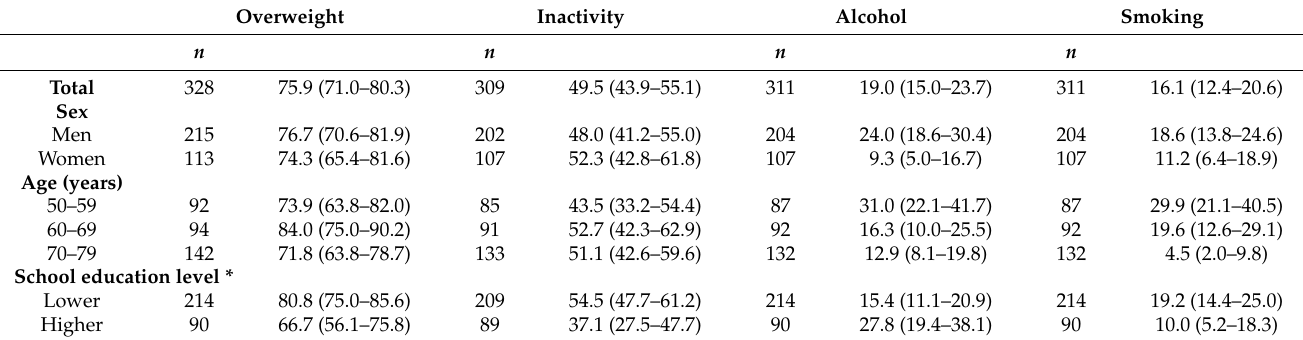
Table 2. Individual behavioral health risk factors (regardless of whether any other health risk factors were present) in the total sample and stratified by sociodemographic characteristics (percent, 95% confidence